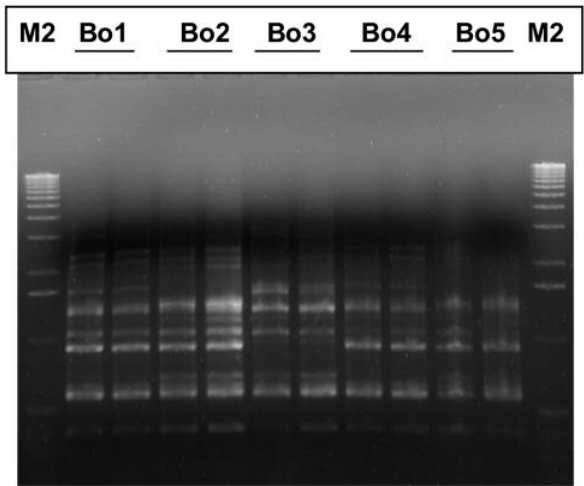
Figure 1 RAPD amplification profiles of five individual plants belonging to “Votomos” using primer OPG2 and a hot-start pro- cedure. Duplicate samples from each individual were elec- trophoresed in a 1.8% agarose gel (1X TAE buffer). Lanes: M2, molecular mass marker 1.0 kb- DNA ladder. Bo1, Bo2, Bo3, Bo4 and Bo5 are individual “Votomos” plants.